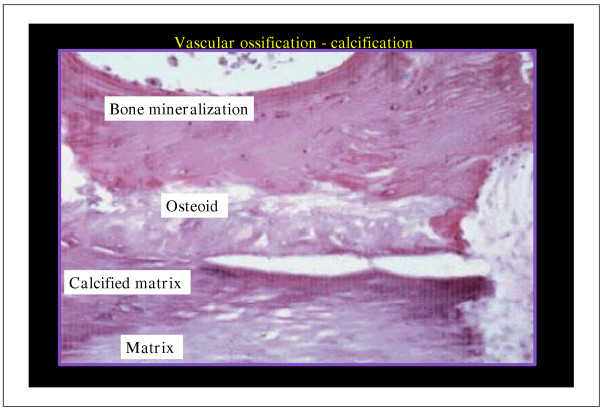
Transitional stages in VOC. Transitional stages in vascular calcification recapitulate embryonic endochondral ossification, including an acellular matrix (matrix), amorphous mineralized matrix (calcified matrix), remodeling (osteoid), and following neovascularization of adventitial Vv vessels, complete bone tissue (bone mineralization).